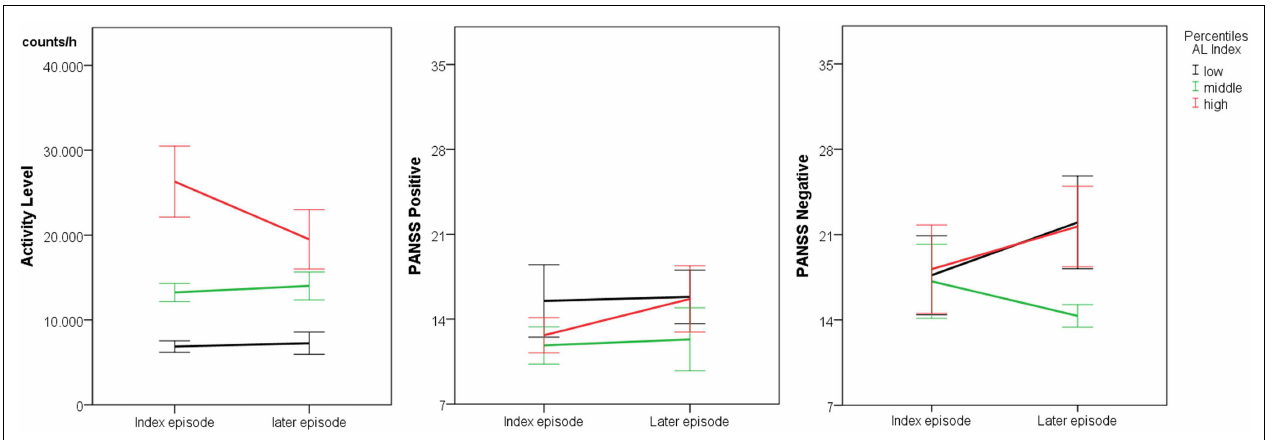
FIGURE 2 | Between episode course of activity and psychopathology ( n = 18) lines indicate mean ± SE